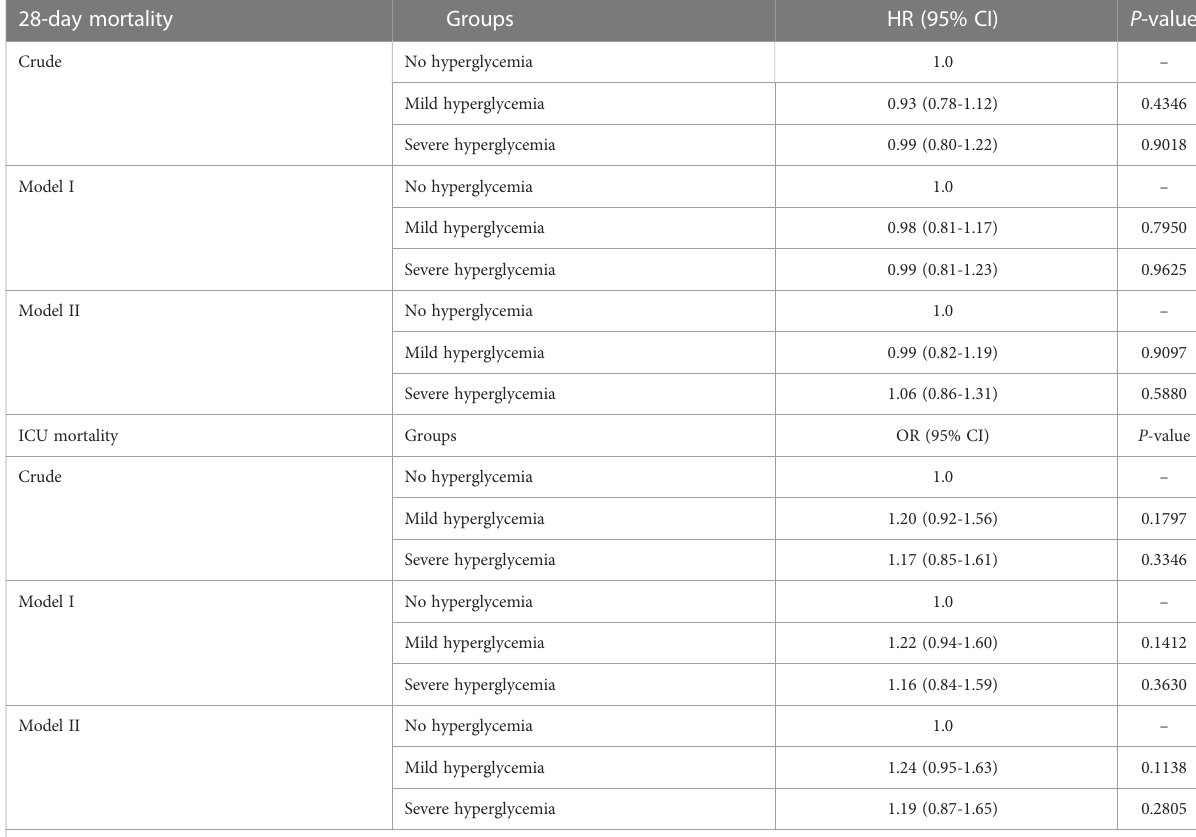
TABLE 2 Association of admission glucose groups with primary and secondary outcomes. 28-day